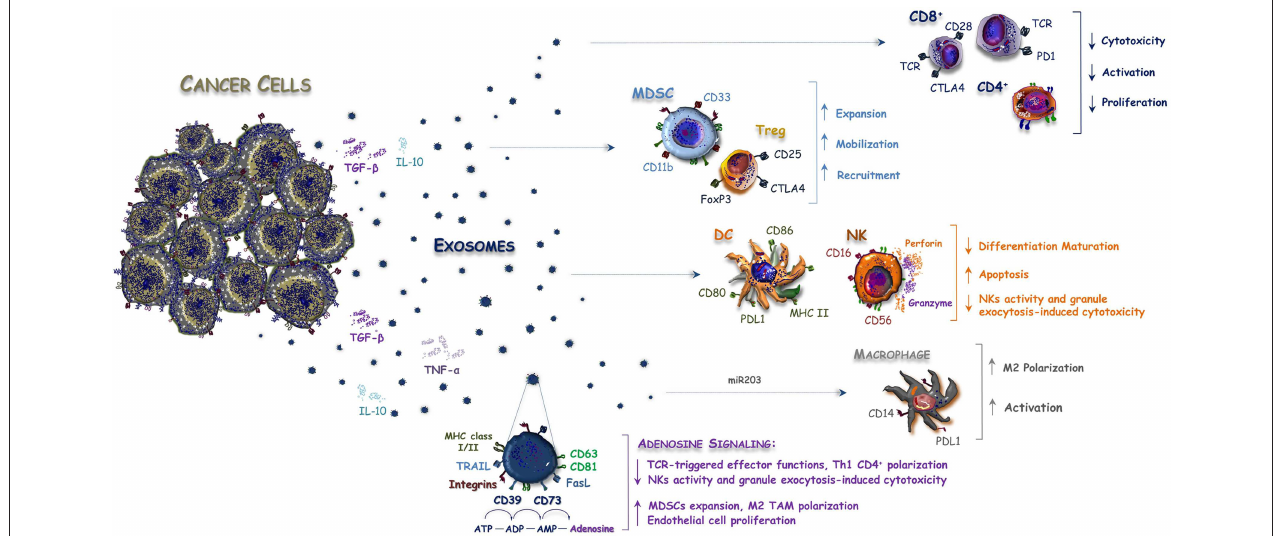
FIGURE 1 | Exosomes released by CRC cells balance immune system activity. Anti-cancer immune response is modulated within the tumor microenvironment by interleukins and Exos released by CRC cells. Exosomes contain both inhibitory and stimulatory molecules that alter the immune system balance by favoring the expansion, mobilization, and recruitment of Tregs and MDSCs or by blocking the activity of CD8 + T-cells, DC, and NK cells. On the other hand, miR-203 bearing Exos are released by CRC cells and internalized by monocytes to promote polarization and activation of M2-macrophages, while CD39/CD79 + Exos increase the amount of immunosuppressive adenosine signaling within the tumor microenvironment, thus further inhibiting the anti-tumor immune